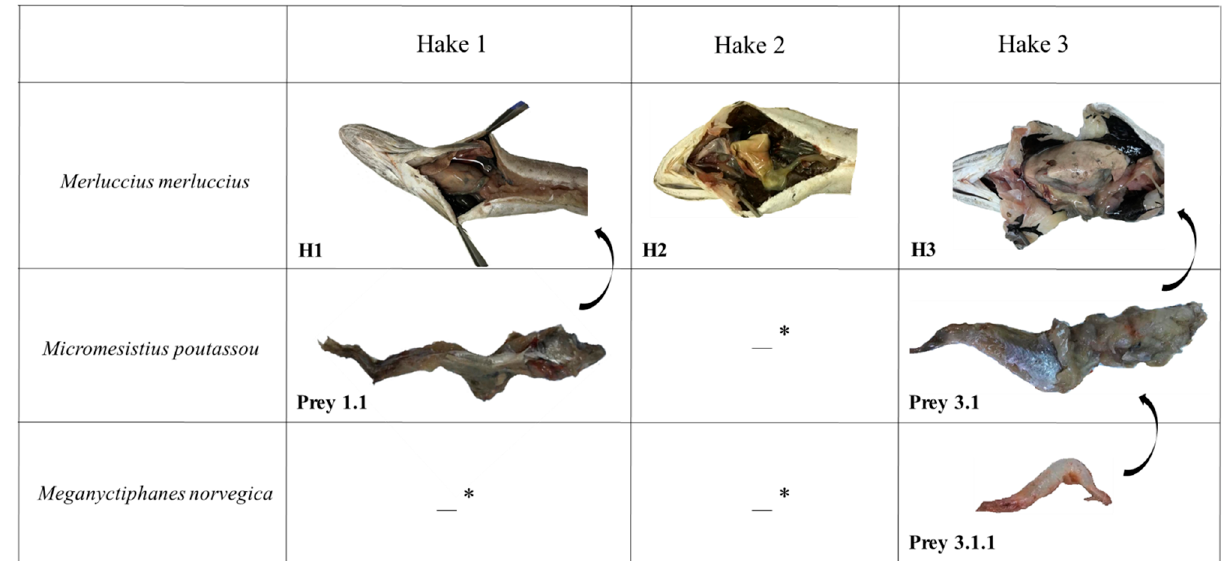
Figure 3. The three individuals of hake ( Merluccius merluccius ) analysed (H1, H2 and H3) and the preys found in the stomachs of H1 (Prey H1.1 Micromesistius poutassou ) and H3 (Prey H3.1 M. poutassou , and Prey H3.1.1 Meganyctiphanes norvegica found inside the stomach of Prey H3.1). * No prey was found inside Prey 1.1 and Hake 2.